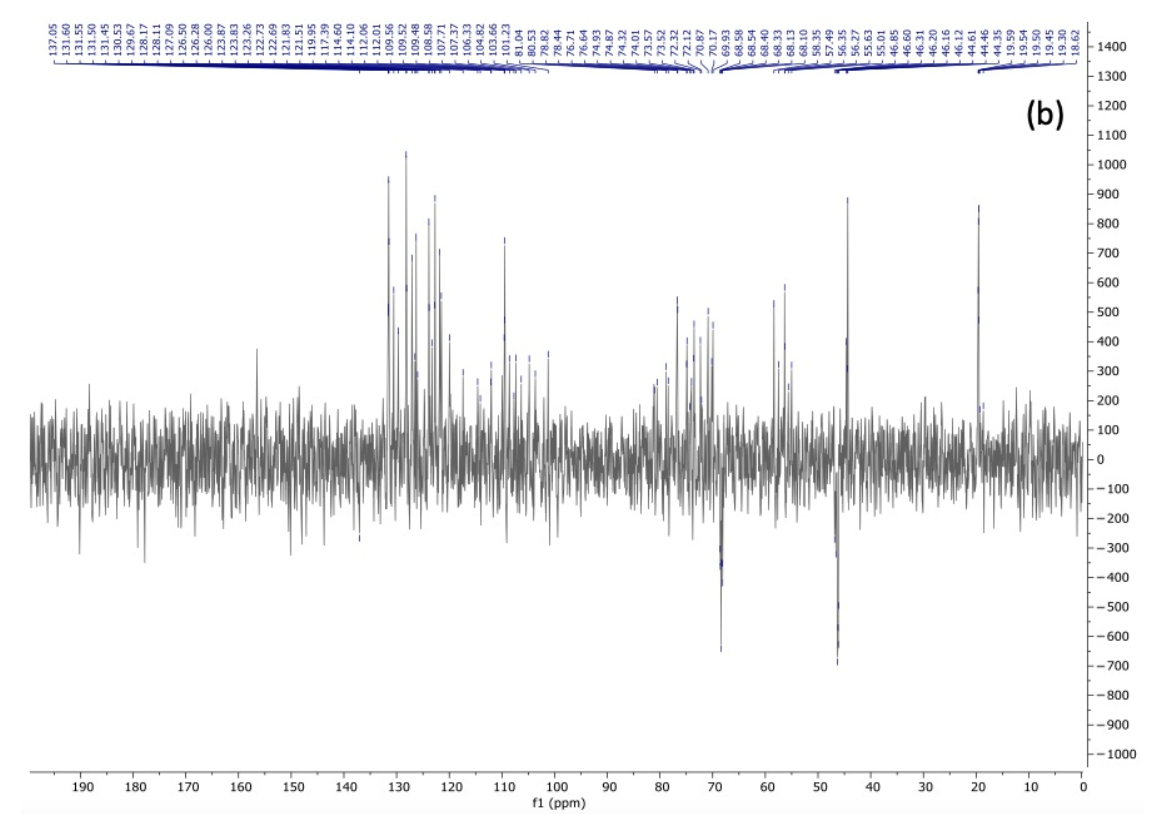
Figure 5. 1 H NMR Spectra of the avoparcin fermentation complex (D 2 O; 400 MHZ—significant sig- nals are integrated) (the D aryl ring signals are shown) ( a ), and 13 C NMR Spectra of the avoparcin fermentation complex (D 2 O; 100 MHZ) ( b ).